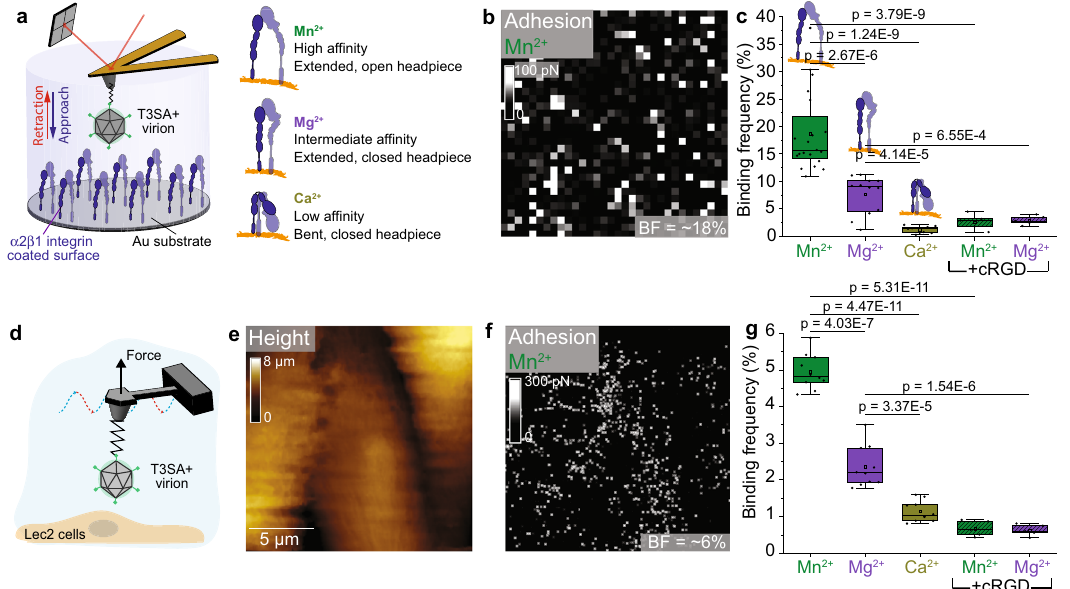
Fig. 2 Reovirus directly engages β 1 integrins in a cation-dependent manner. Studies were conducted using model surfaces ( a – c ) and living cells ( d – g ). a Experimental set up (left) to probe cation-dependent (right) virion- α 2 β 1 integrin interactions using a model surface. b The adhesion map shows interaction forces (white pixels) between virions and integrins in the presence of Mn 2 + , which induces an extended integrin conformation. c Box plot of speci fi c binding frequencies (BF) measured using AFM between virions and integrins in the presence of divalent cations and following injection of cRGD. d FD-based AFM setup to study T3SA + binding to Lec2 cells, which express β 1 integrins. Height ( e ) and corresponding adhesion maps ( f ) of the imaged area show speci fi c binding of reovirus T3SA + to living Lec2 cells in the presence of Mn 2 + (white pixels). For better visibility, the pixel size in the adhesion image was enlarged two-fold. AFM images were acquired using an oscillation frequency of 0.25 kHz and amplitude of 750nm under cell culture conditions. g Box plot shows BF of T3SA + virions to β 1 integrins on living Lec2 cells under conditions shown. The horizontal line within the box indicates the median, boundaries of the box indicate the 25th and 75th percentile, and whiskers indicate the highest and lowest values. Open square within each box indicates the mean. All data are representative of N = 5 independent experiments. P values were determined by two-sample t -test using